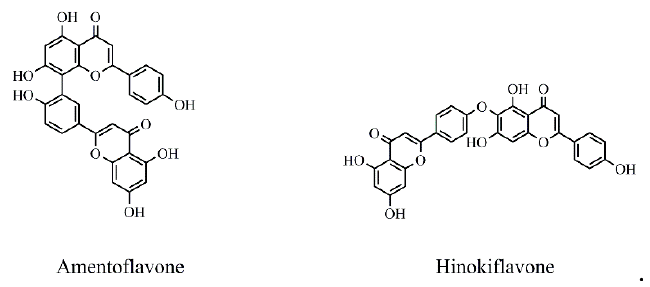
Figure 1. Chemical structures of two biflavonoids from S. sinensis.